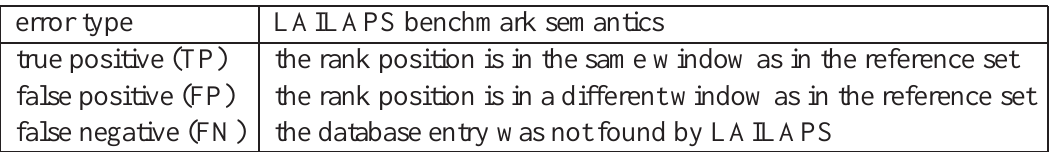
Table 3: Definition of evaluation error types.